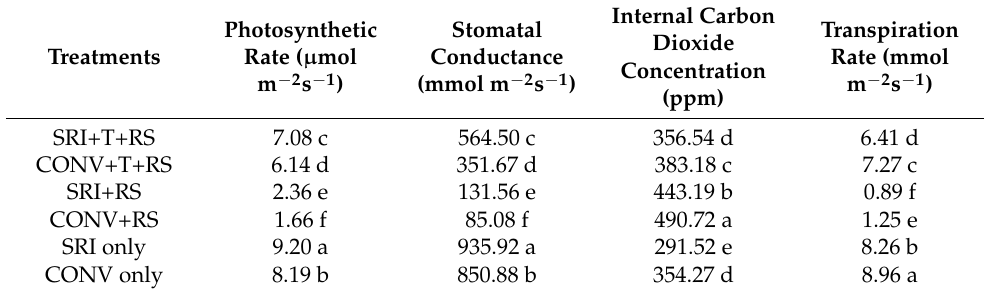
Table 4. Rice plant physiological responses to R. solani infection.